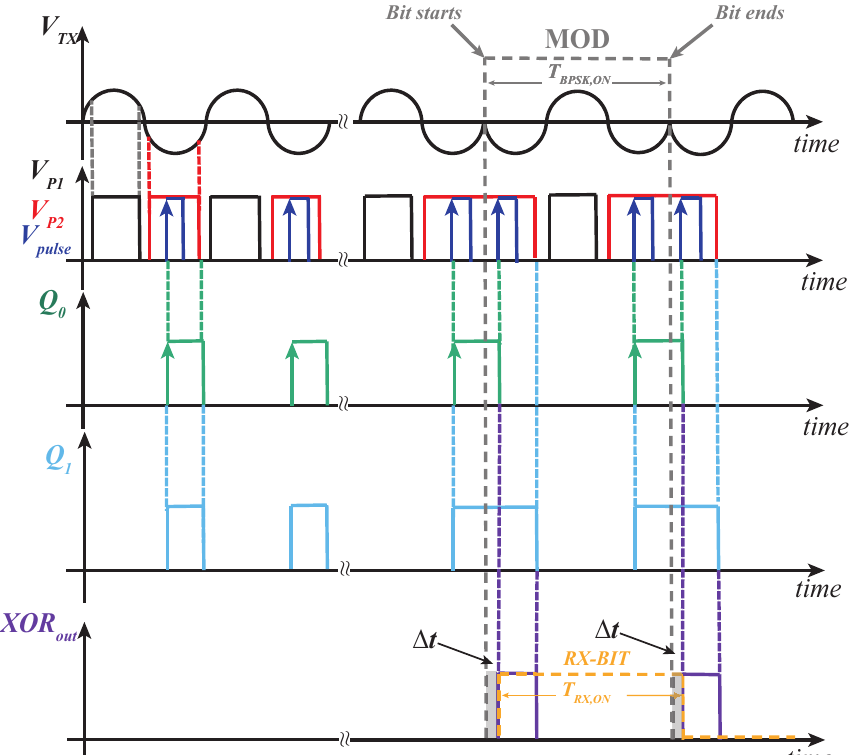
Figure 7. Timing diagram of the proposed demodulator